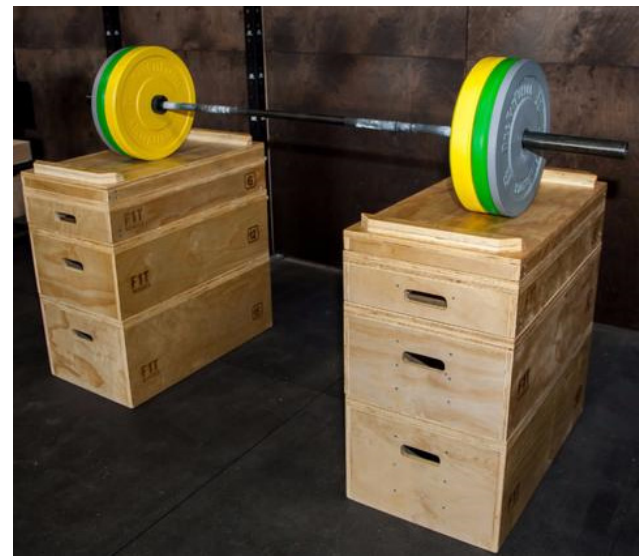
Figure 5. Weightlifting barbell loaded with bumper plates placed on plywood jerk boxes. Reprinted with the permission of Reference [28]. Copyright 2008 Fringe Sport.